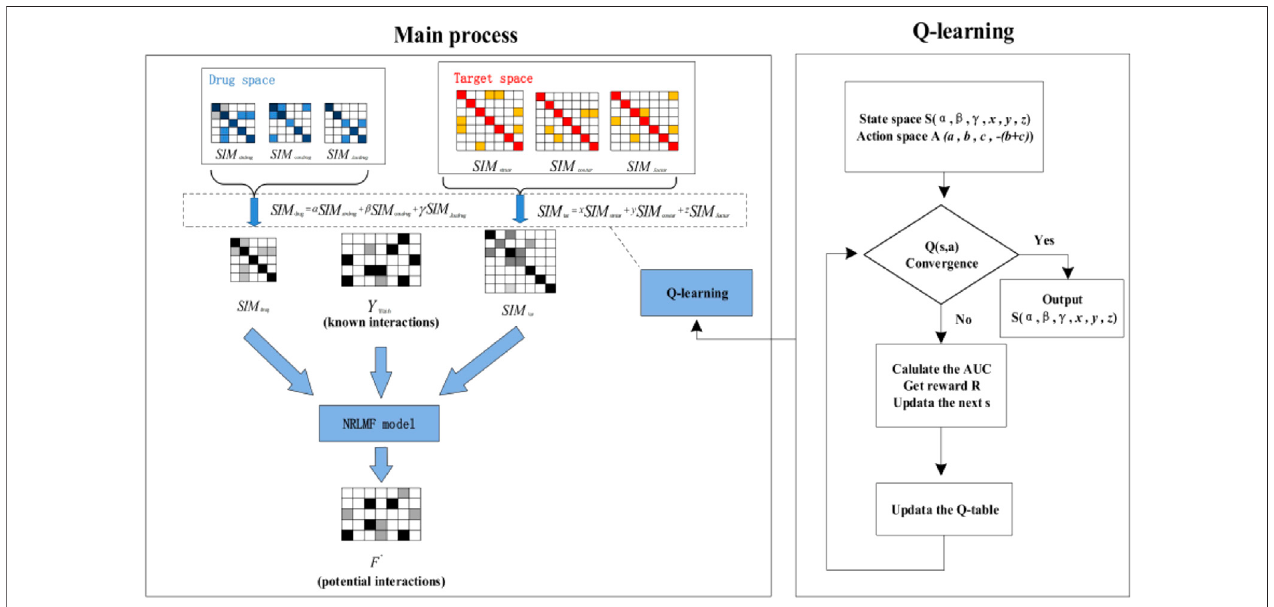
FIGURE 2 | Algorithm fl ow